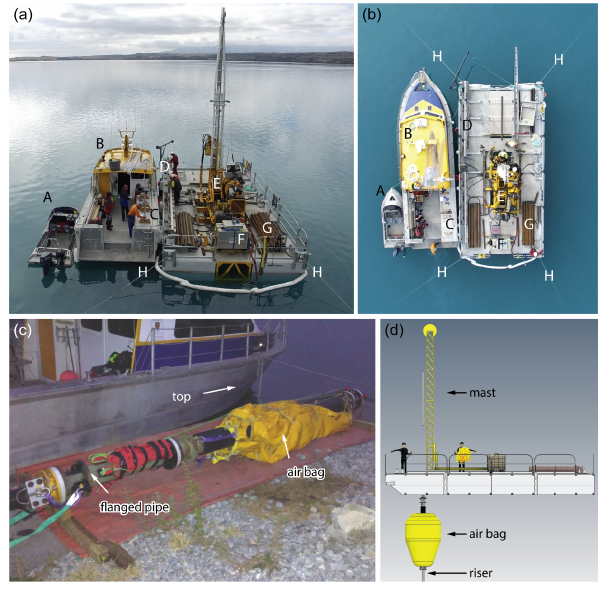
Figure 4. (a, b) – Photographs of the drill system deployed at Lake Ohau shown from stern view (note LGM terminal moraine in dis- tance) and from above. A – alloy support vessel used to transport core to shore; B – RV Beryl Brewin ; C – core curation area; D – coring tool work area; E – Webster Drilling HPP 600 rig; F – dou- ble lined 350L rig fuel tank; G – drill pipe; H – anchor lines. (c, d) – air bag attached to flanged pipe in pre-deployment configura- tion lying beside tender vessel; schematic diagram of barge and air bag in deployed